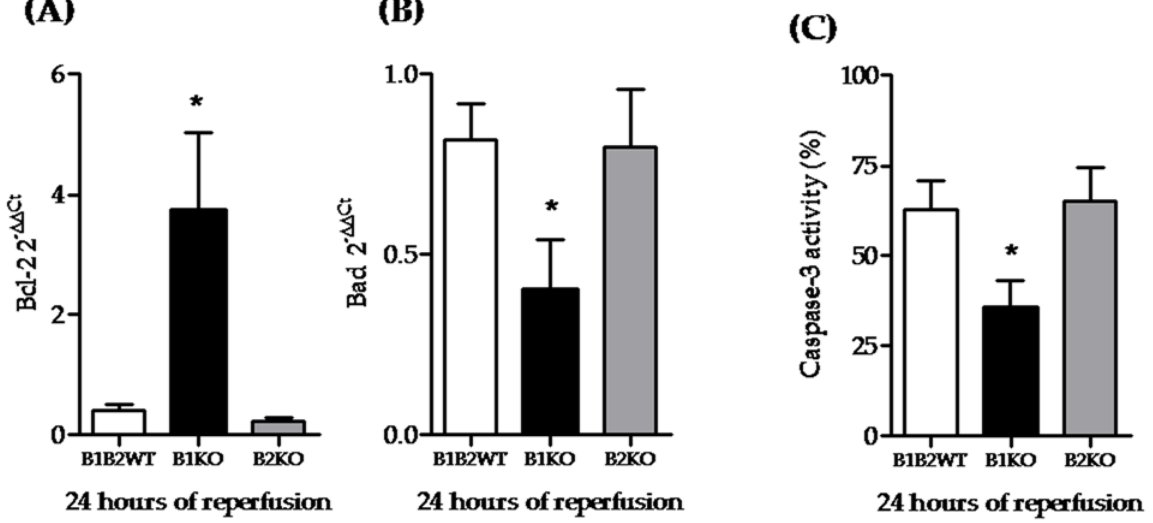
Figure 3. Cell death modulation under B1R-knockout. Apoptosis was estimated by Bcl-2 and Bad expression and caspase-3 activity, at 24 hours of reperfusion. Bcl-2 and Bad expression were measured by real-time PCR, and caspase-3 activity by fluorimetric assay. B1KO animals presented higher Bcl-2 expression (A) along with lower Bad expression (B) and caspase-3 activity (C), indicating a lower degree of apoptosis. Statistical analyses were performed using ANOVA.* B1KO versus B1B2WT and B2KO, p , 0.05.